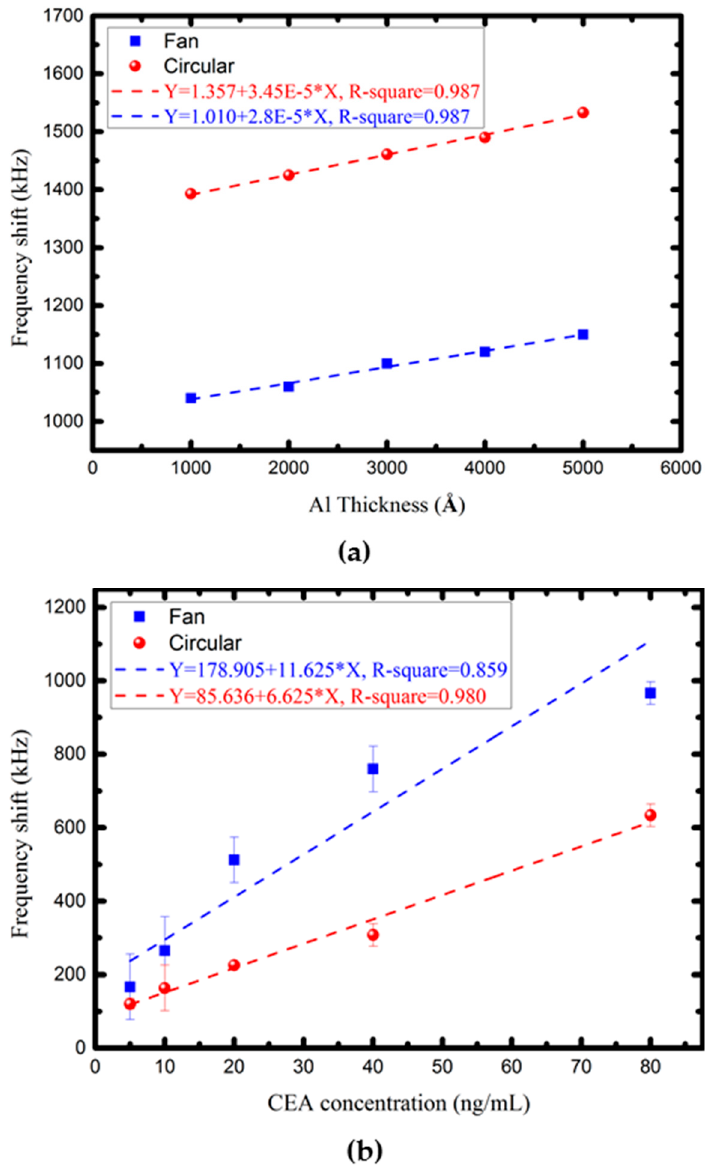
Figure 10. Measured frequency shift of ( a ) the FPW device under five different Al mass loadings and ( b ) the FPW-CEA biosensor under five different CEA antigen concentrations.